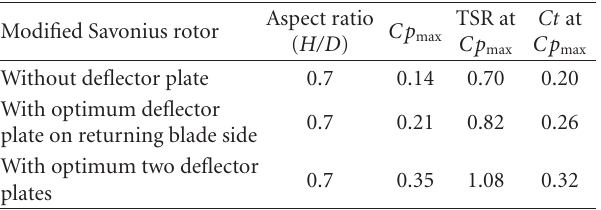
Table 4: Cp max and corresponding TSR and Ct of modified Savo- nius rotors with and without deflector